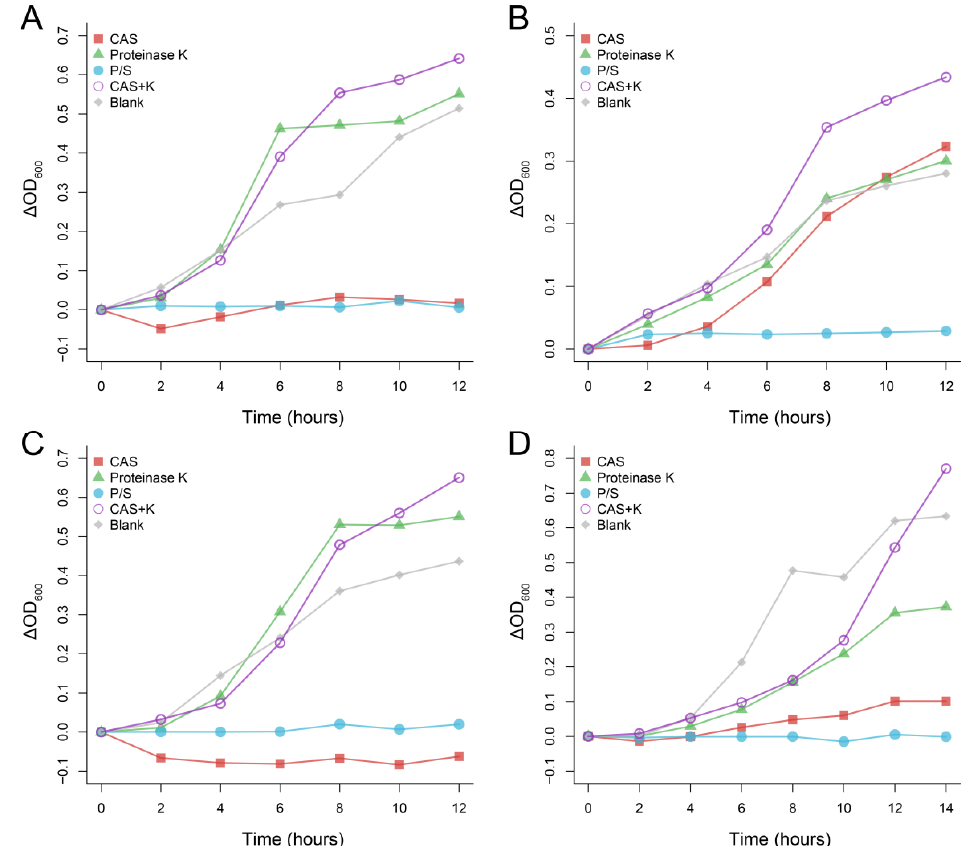
Figure 3. Antibacterial effect of Chinese alligator serum after proteinase K treatment on Klebsiella pneumoniae ( A ), Staphylococcus aureus ( B ), Escherichia coli ( C ) and Pseudomonas aeruginosa ( D ). Changes in absorbance were obtained by comparing the absorbance of each sample at different times with the initial absorbance. CAS: Chinese alligator serum, P/S: Penicillin-Streptomycin Solution, K: proteinase K.